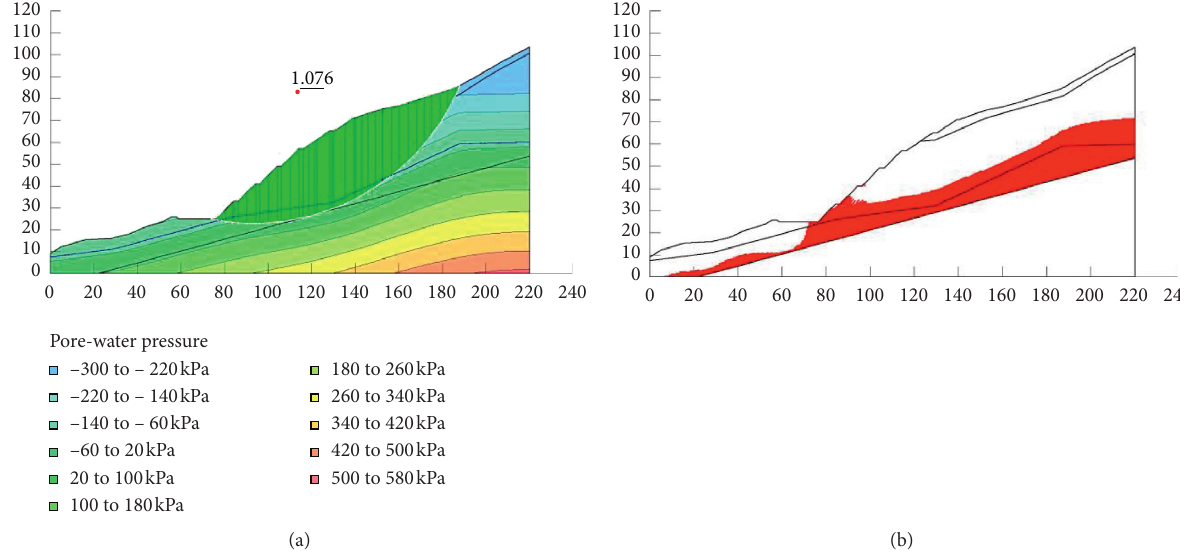
Figure 8: (a) Pore water pressure contour; (b) plastic zone distribution of the completed slope before